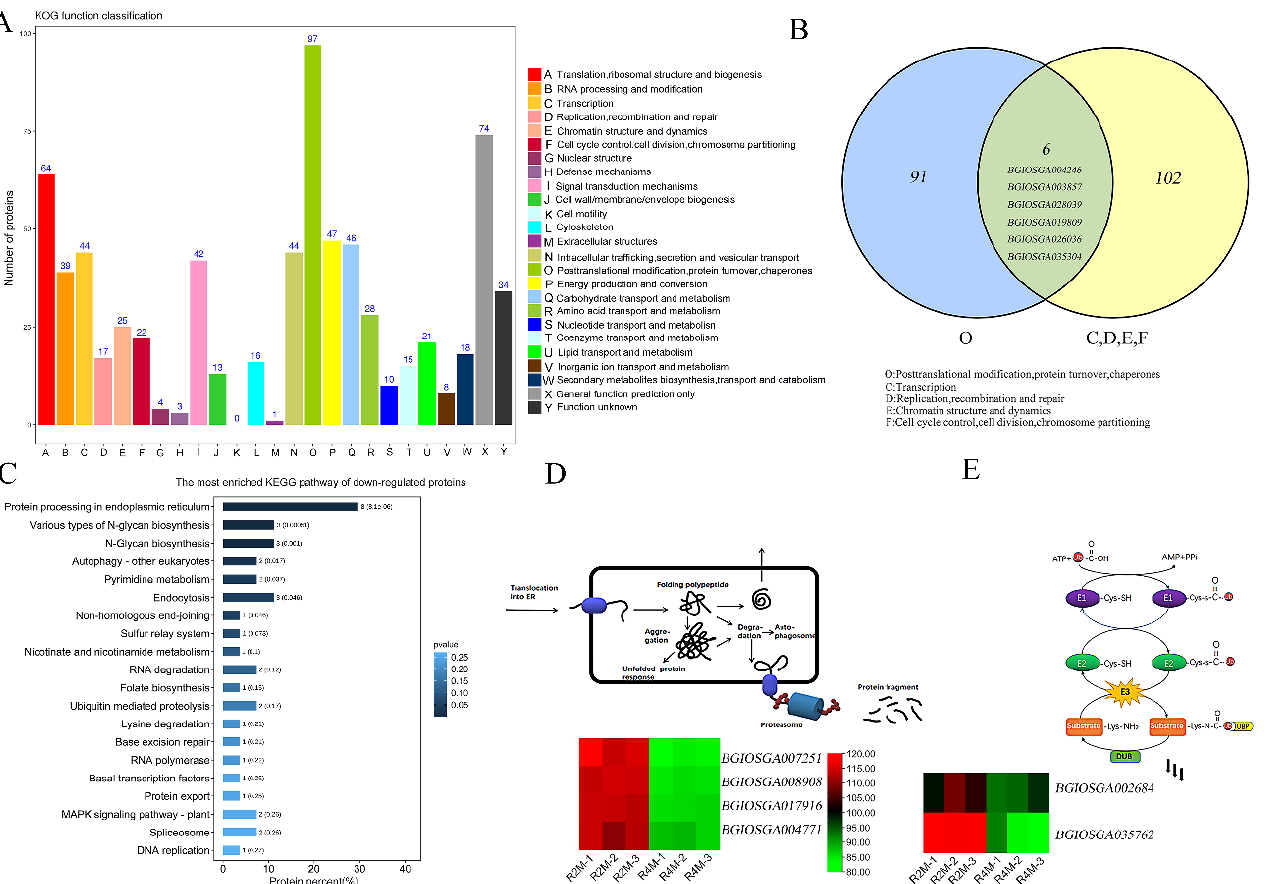
Figure 5. Correlation analysis between ERAD (ER–associated degradation) and protein ubiquitination. ( A ) KOG (Clusters of Orthologous Groups of proteins) functional classification of the differentially expressed proteins; ( B ) Venn diagram of O and C, D, E, and F; ( C ) KEGG (Kyoto Encyclopedia of Genes and Genomes) analysis of protein-degradation-related genes; ( D ) overview of the ERAD pathway; ( E ) overview of the protein ubiquitination process.